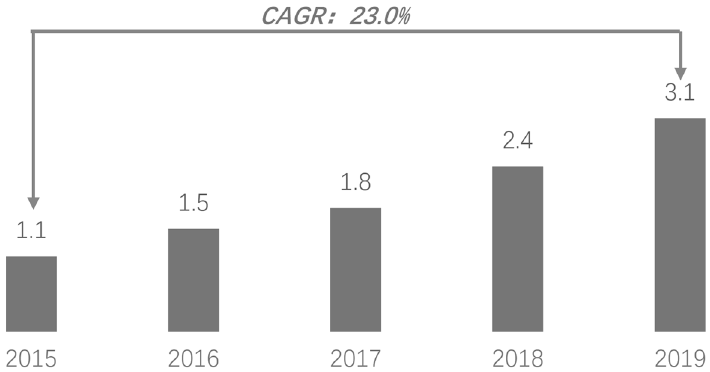
Figure 7. Global IoT module shipments from 2015 to 2019.